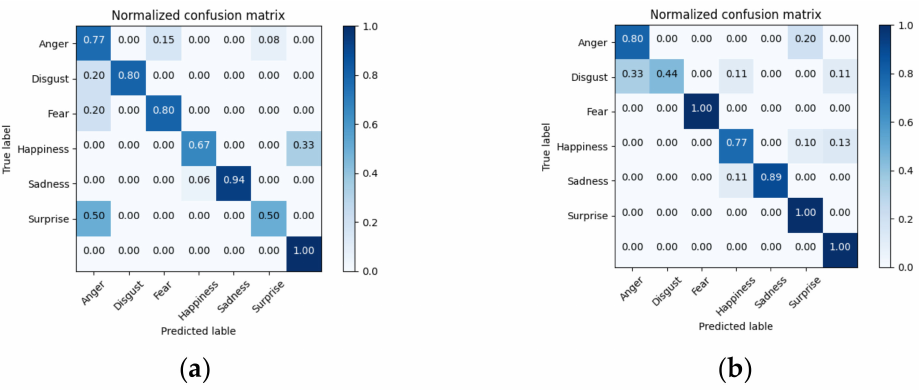
Figure 7. The confusion matrices of different methods on the CK+ dataset: ( a ) baseline. ( b ) our proposed method.